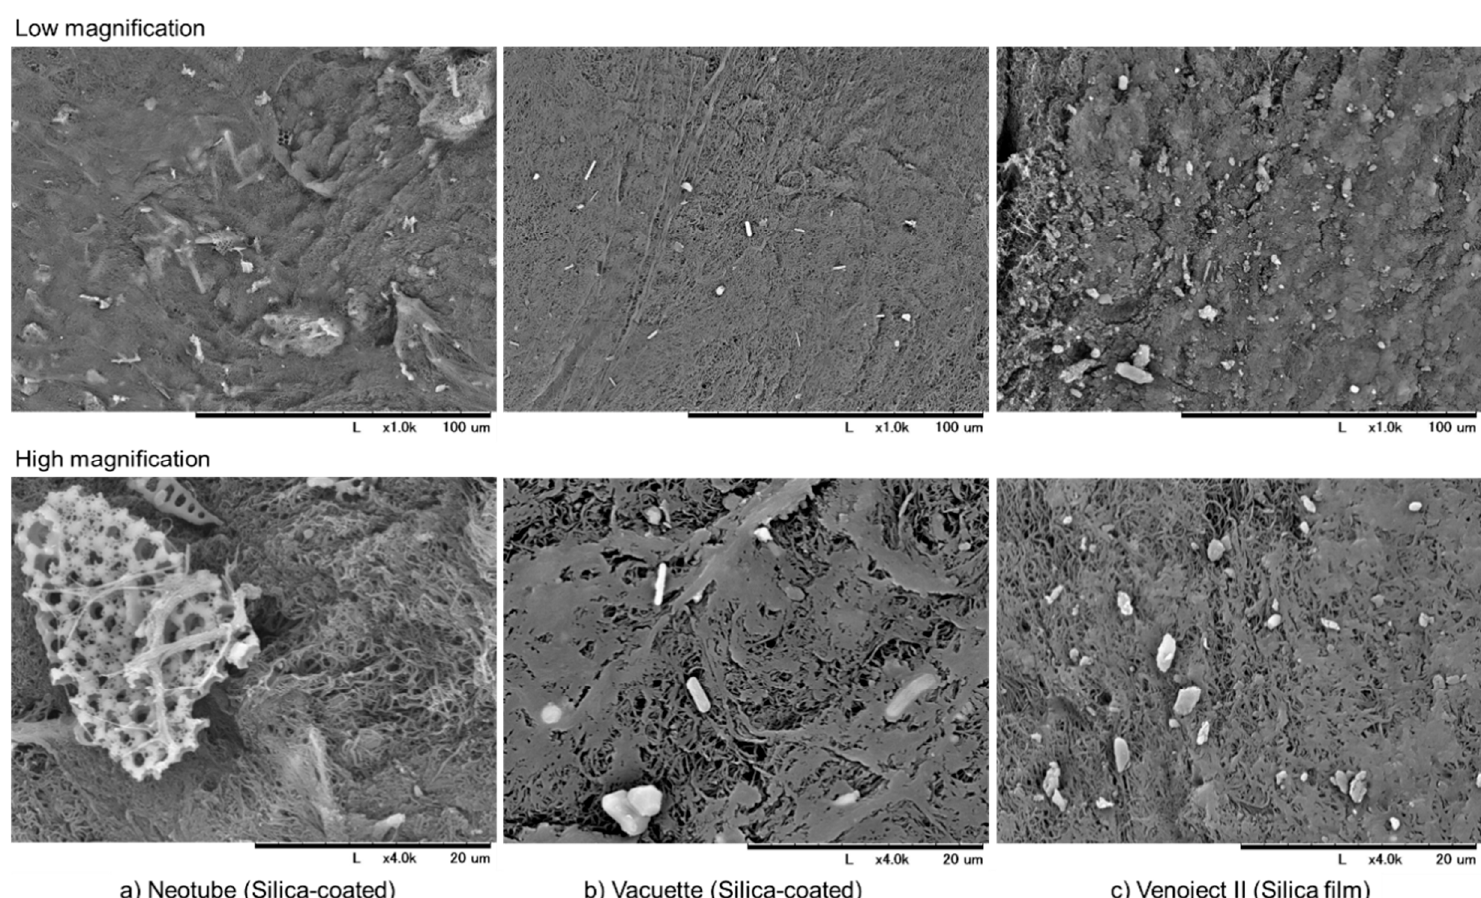
Figure 4. SEM observations of silica microparticles embedded in and attached to individual A-PRF-like matrices prepared by ( a ) Neotube, ( b ) Vacuette and ( c ) Venoject II.